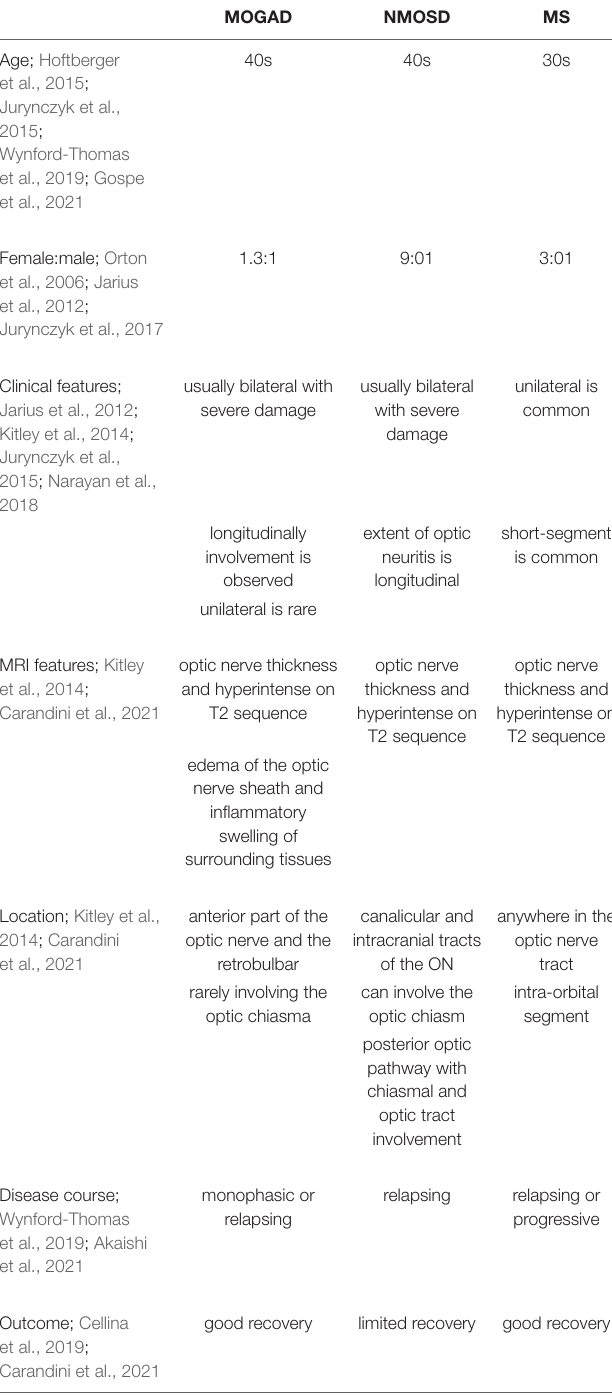
TABLE 1 | Optic neuritis comparison between MS, NMOSD, and MOGAD. MOGAD NMOSD